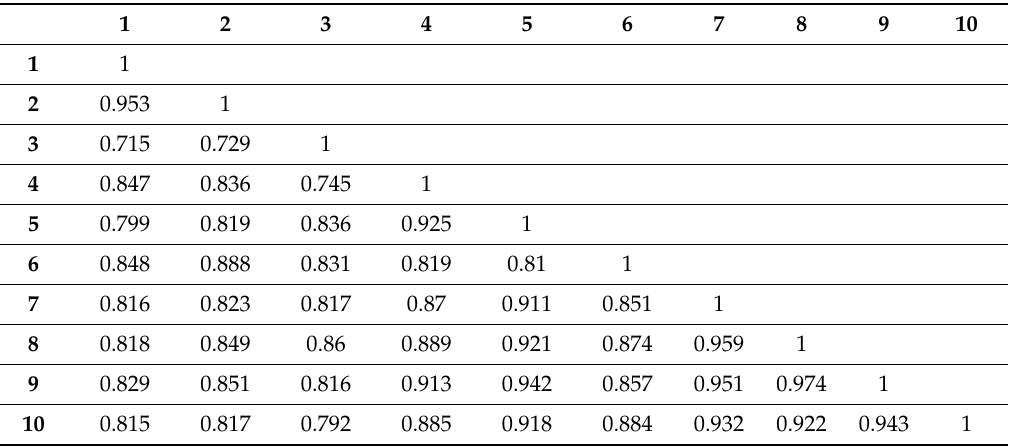
molecular attributes using the SYSTAT version 7.0